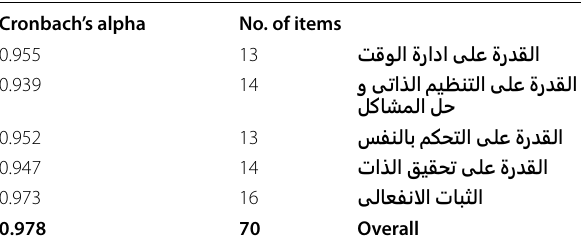
Table 1 Comparison between the different studied groups according to different scores